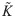
Successful adaptation of Besag’s boundary correction at non-binary fields of view.The normalized and centered K-function (K˜), as described by Lagache et al, was calculated at different particle intensities and radii using simulated square fields of view measuring 256 x 256 pixels, with a homogeneous Poisson distribution of particles (Complete Spatial Randomness). Densities are expressed in particles per pixel. Besag’s boundary correction was applied to all particles within the field of view and not just border pixels, as described in the text and in Fig 2. Panels A and B: The black line represents the mean K˜ and the dotted lines represent the upper and lower critical quantiles (Q01 and Q99). In order to ensure convergence, each mean/quantile was determined using a set of 25,000 simulations. The red dotted lines represent the Cornish-Fisher expansion used to estimate the critical quantiles, as validated by Lagache et al., while the green dotted lines represent the normal quantiles. Unlike the other unsuccessful implementations shown in Figs 3 and 4, mean K˜ remains centered on zero even at very high particle densities. Panel C: Quantifying relative error in the Cornish-Fisher expansion estimation of the empirically-determined critical quantiles.